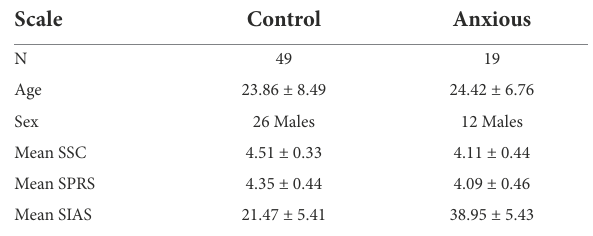
TABLE 9 Demographic description of the sample used for discriminant